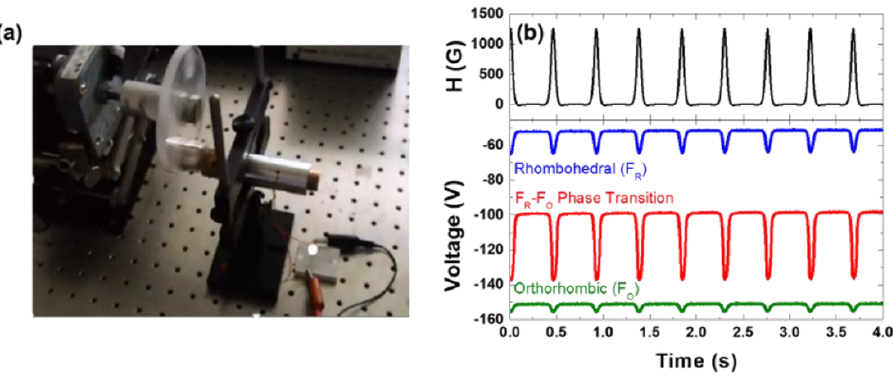
Figure 5. ( a ) Prototype energy harvester design (patent pending) [17] using Terfenol-D as the magnetostrictor (see video in the Supplementary Files) and ( b ) voltage response measured over a 22 nF capacitor generated by rotating magnets.